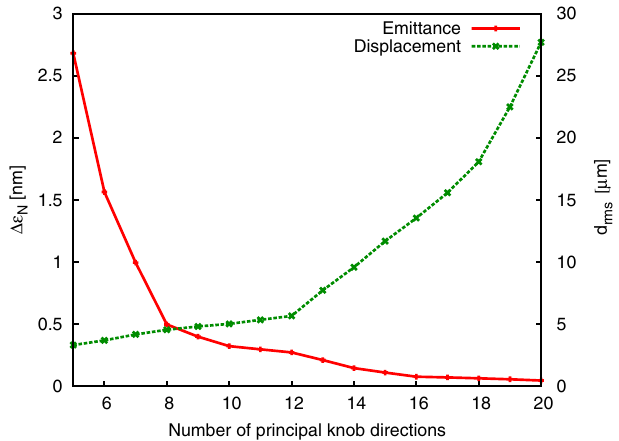
FIG. 15. Estimate of the average rms displacement and the average remaining emittance growth of 100 CLIC seeds for different numbers of principal knob directions.